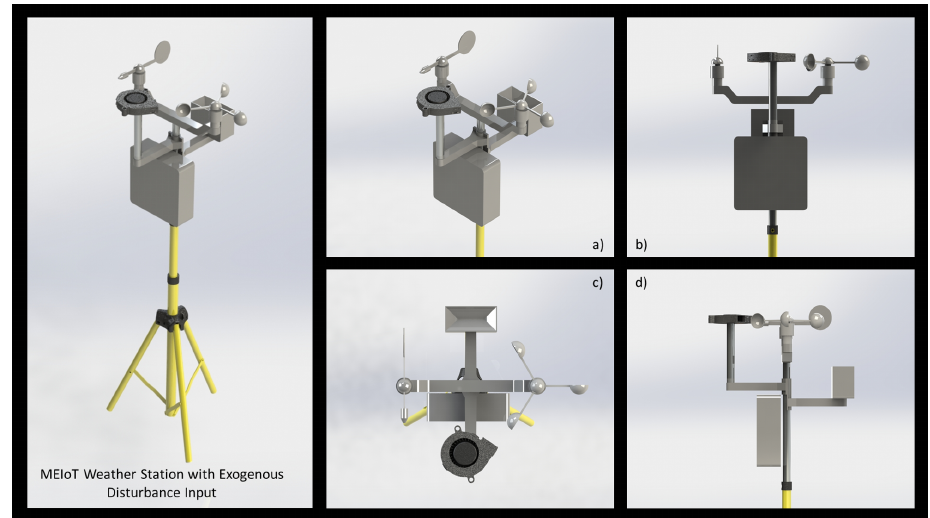
Figure 2. 3D model design of the MEIoT weather station with exogenous disturbance input. ( a ) Isometric view, ( b ) front view, ( c ) top view, and ( d ) right